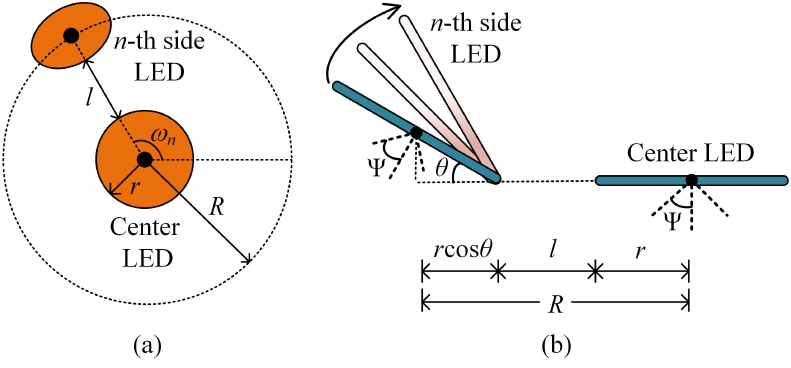
Figure 2. ( a ) Top view and ( b ) side view of the ADT. Only the center LED and the n -th side LED are shown for